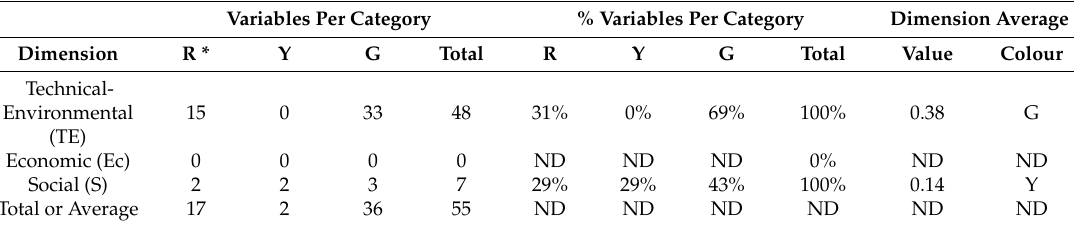
Table 9. Sustainability performance per dimension: Tepeji site. Variables Per